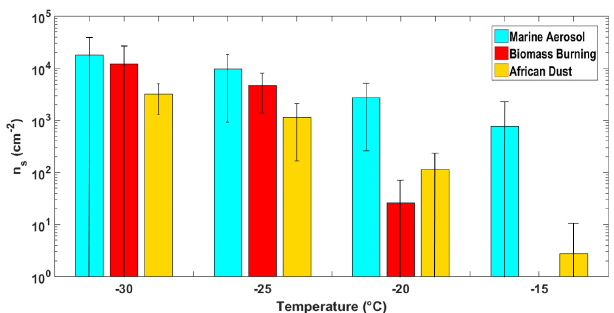
Figure 8. Surface active site density ( n s ) as a function of temper- ature for MA, BB, and AD particles. The error bars represent the standard